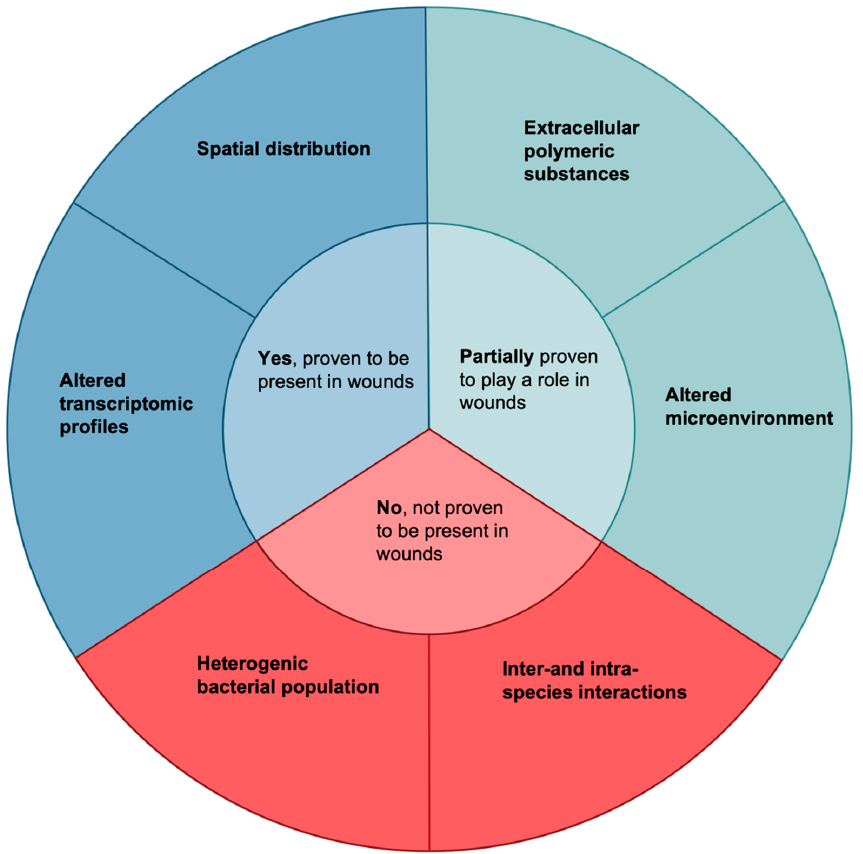
Figure 1. Factors that may cause increased survival of bacteria in wounds. These six qualities are all biofilm attributes or biofilm-related attributes which have been speculated to increase their survival in human wounds. Only two have been demonstrated to exist and lead to increased biofilm survival in wounds by use of clinical wound samples, namely altered transcriptomic profiles [36–39] and spatial distribution [40,41]. Two factors have been partially proven to play a role: extracellular polymeric substances [42–48] and an altered microenvironment [49–61]. Both of these factors have been shown to exist in wounds, but their role in leading to increased survival has not been proven in clinical samples. Finally, the last two factors, a heterogenic bacterial population and inter-and- intra-species interactions, have only been shown to exist in vitro or in other